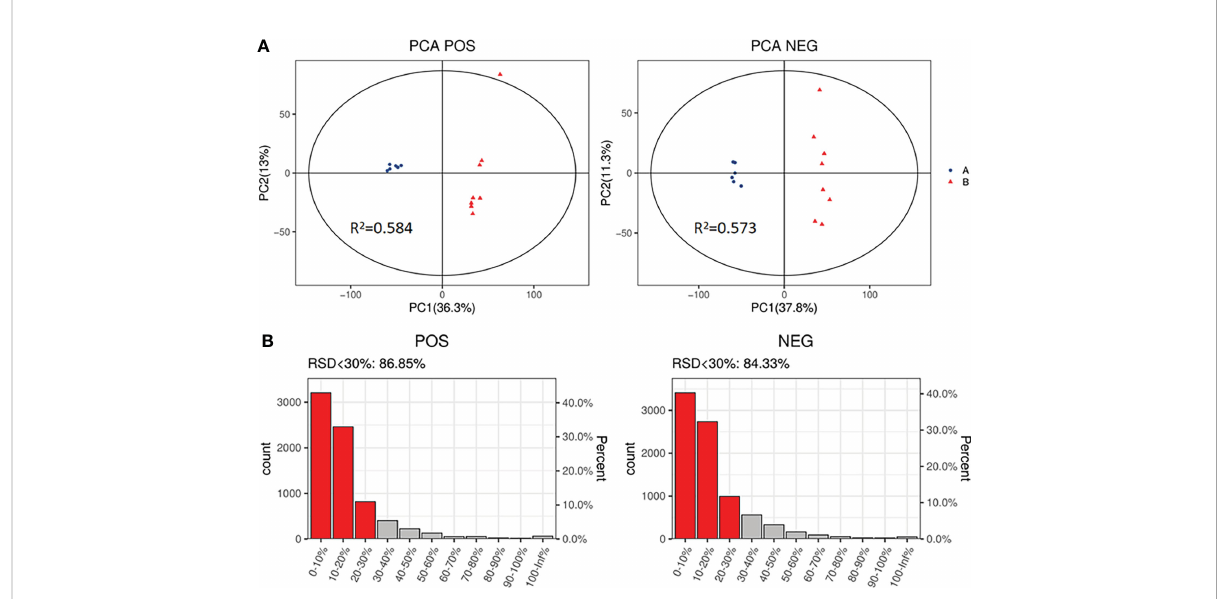
FIGURE 4 PCA score plot of SADI-S group and sham operation group in the positive ion mode and in the negative ion mode (A) ; quality assurance in the positive ion mode and in the negative ion mode (B) . A=SADI-S group, B=sham operation